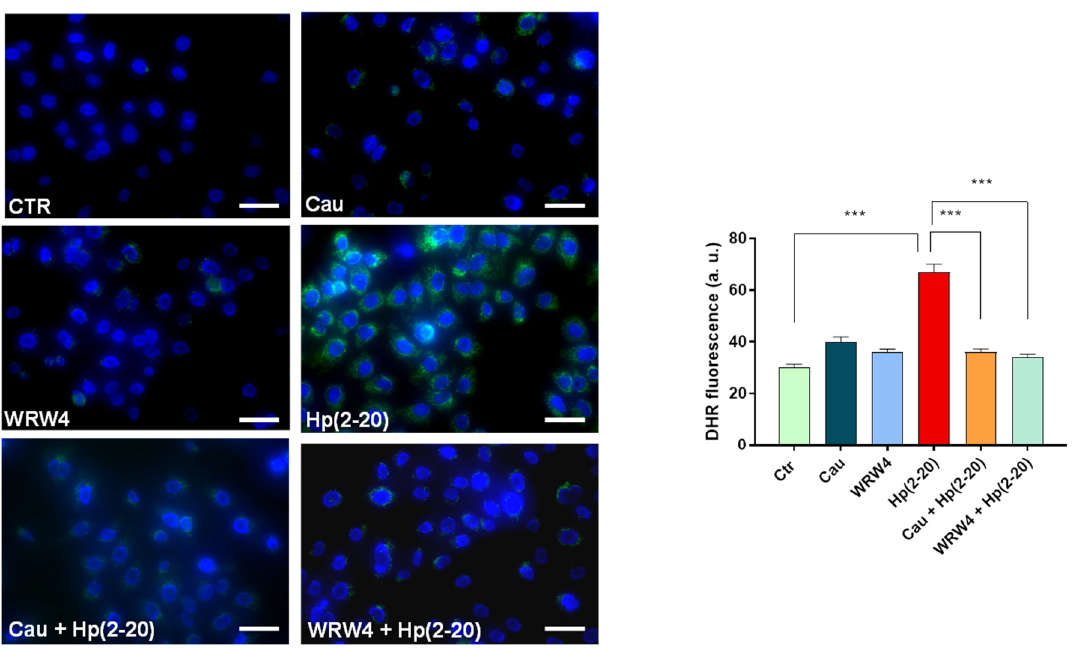
Figure 5. Cau moderates FPR2-mediated ROS production. DHR-loaded cells differently treated: (1) control cells; (2) Hp(2– 20) 25 µ M for 1 h; (3) Cau 15 µ M for 1.5 h; (4) WRW4 10 µ M for 1.5 h; (5) Cau 15 µ M for 30 min and Hp(2–20) 25 µ M for 1 h; (6) WRW4 10 µ M for 15 min and Hp(2–20) 25 µ M for 1 h, observed with a fluorescence microscope (on the left, scale bar: 100 µ m) and quantification of the mean fluorescence of individual cells (on the right). Results are expressed as arbitrary units and represent the mean ± SD calculated from three independent experiments, each performed in duplicate. Statistical analysis was performed by GraphPad Prisma software, using one-way ANOVA followed by Bonferroni post hoc correction. *** p < 0.0001.